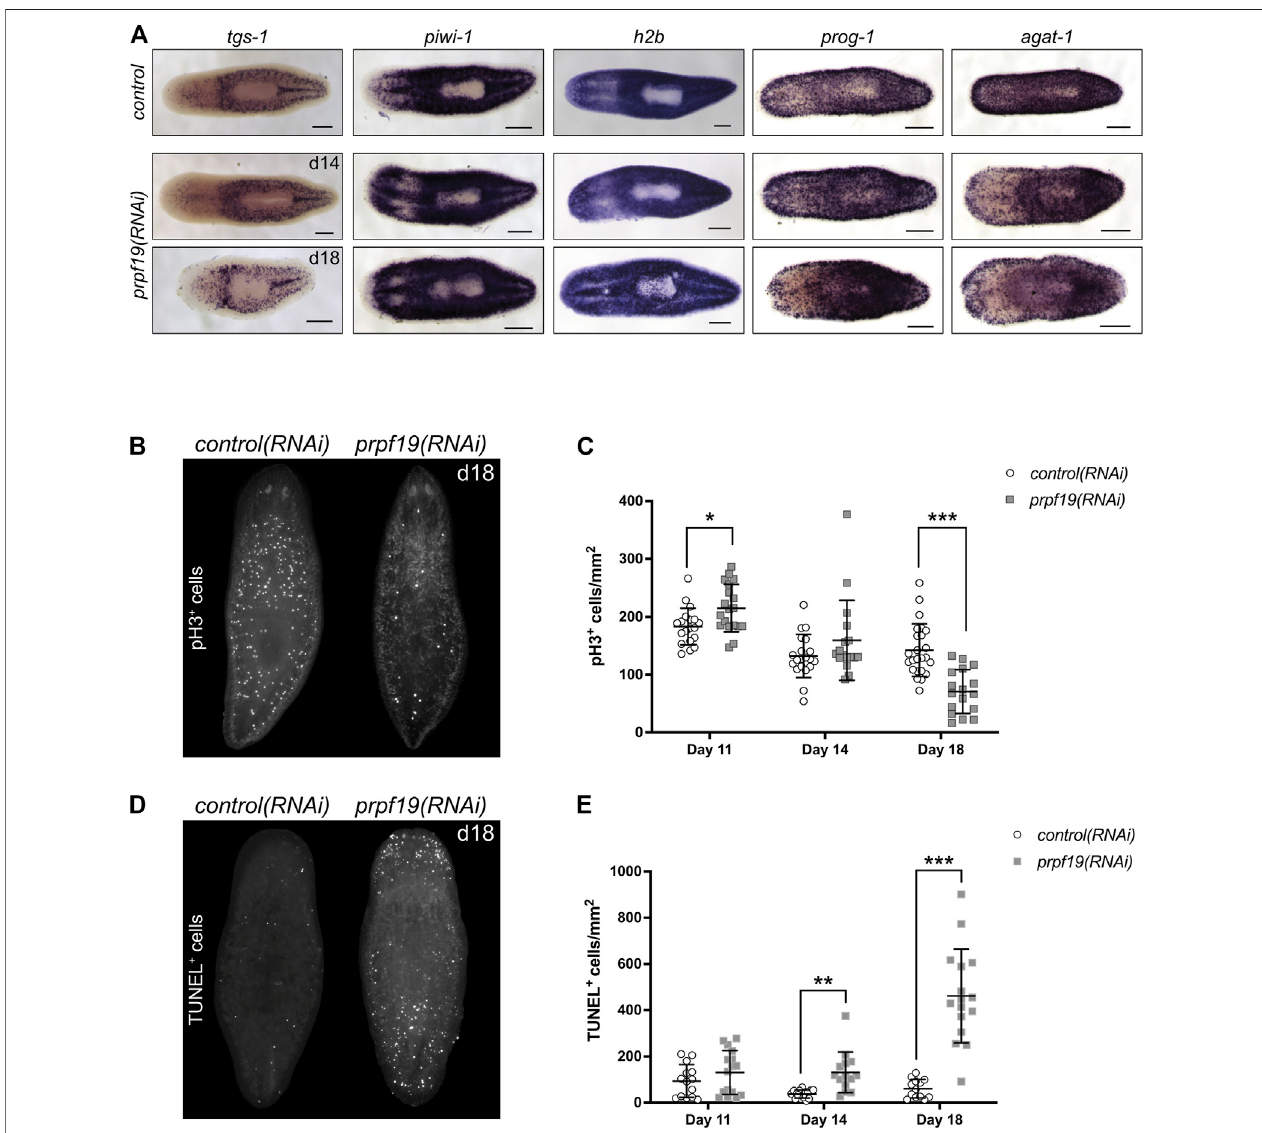
FIGURE3| Inhibition of prpf19 disruptsstemcellfunctionbut isnotrequiredforstemcellmaintenance. (A) WISHtostemcellmarkers tgs-1 (N (cid:1) 10 – 11), piwi-1 (N (cid:1) 7 – 9) and h2b (N (cid:1) 4), and early and late epidermal progeny markers prog-1 (N (cid:1) 7 – 9) and agat-1 (N (cid:1) 8 – 9), respectively, in control(RNAi) (upper panels) and prpf19(RNAi) animalsat14(middlepanels)and18(bottompanels)daysafter fi rstRNAifeeding. (B) Representativeimageofanimals fi xed18 daysafter fi rstRNAifeeding for control(RNAi) (left,N (cid:1) 24)or prpf19(RNAi) (right,N (cid:1) 17)andimmunostained formitoticmarkerphospho-histoneH3 (C) Quanti fi cationofphospho-histoneH3 + cells per mm 2 of worms fi xed at 11, 14, and 18 days after fi rst RNAi feed (N (cid:1) 17 — 24 per time point). (D) Representative image of animals fi xed 18 days after fi rst RNAi feedingfor control(RNAi) (left,N (cid:1) 13)or prpf19(RNAi) (right,N (cid:1) 16)andprocessed forTUNELstaining. (E) Quanti fi cationofTUNEL + cellspermm 2 ofworms fi xedat11, 14, and 18 days after fi rst RNAi feed (N (cid:1) 13 — 16 per time point). All data are represented as mean ± SD. * p -value < 0.05, ** p -value < 0.001, *** p -value < 0.0001, Student ’ s t-test with Holm-Sidak correction for multiple comparisons. Scale bars (cid:1) 200 μ